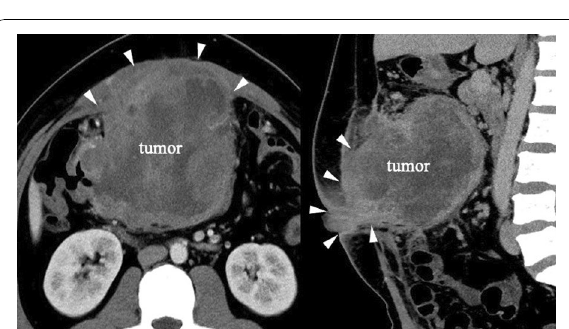
Fig. 2 Contrast-enhanced CT scan findings at initial examination. Enhanced CT shows a large tumor with extensive direct invasion (approximately 12 cm, white arrowhead) of the anterior abdominal